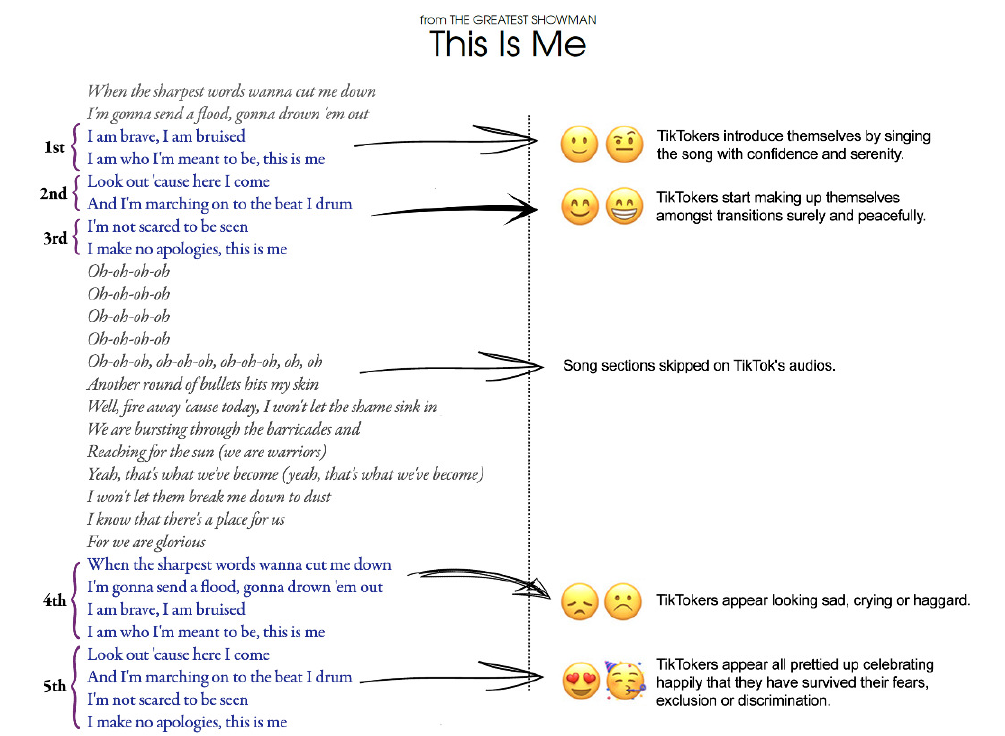
Figure 1. Comparing the original “This Is Me” lyrics and the audio’s TikTok lyrics. Considering that our aim in this stage of the analy‐ sis was to relate both variables, prior to the selection of the correlation statistical test we administered the Kolmogorov‐Smirnov test of the equality of continuous and one‐dimensional probability distributions (as n ≥ 50).